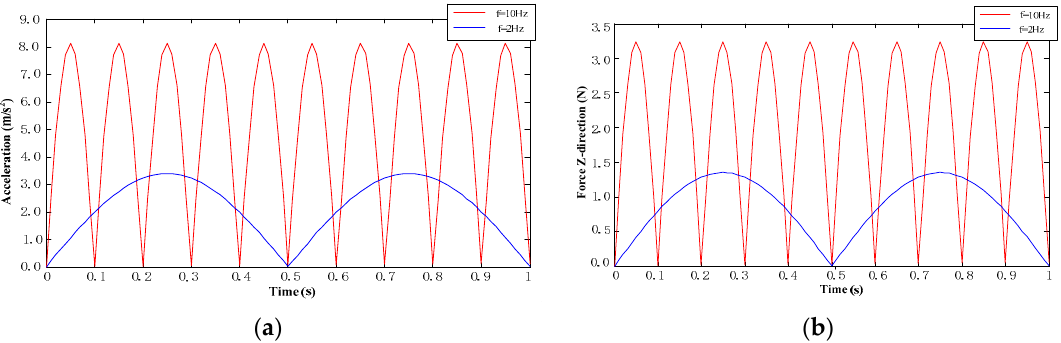
Figure 4. When the frequency is 10 Hz, the magnetic field distribution nephogram at 1 s. ( a ) Sche- matic diagram and semisectional view; ( b ) finite element diagram.